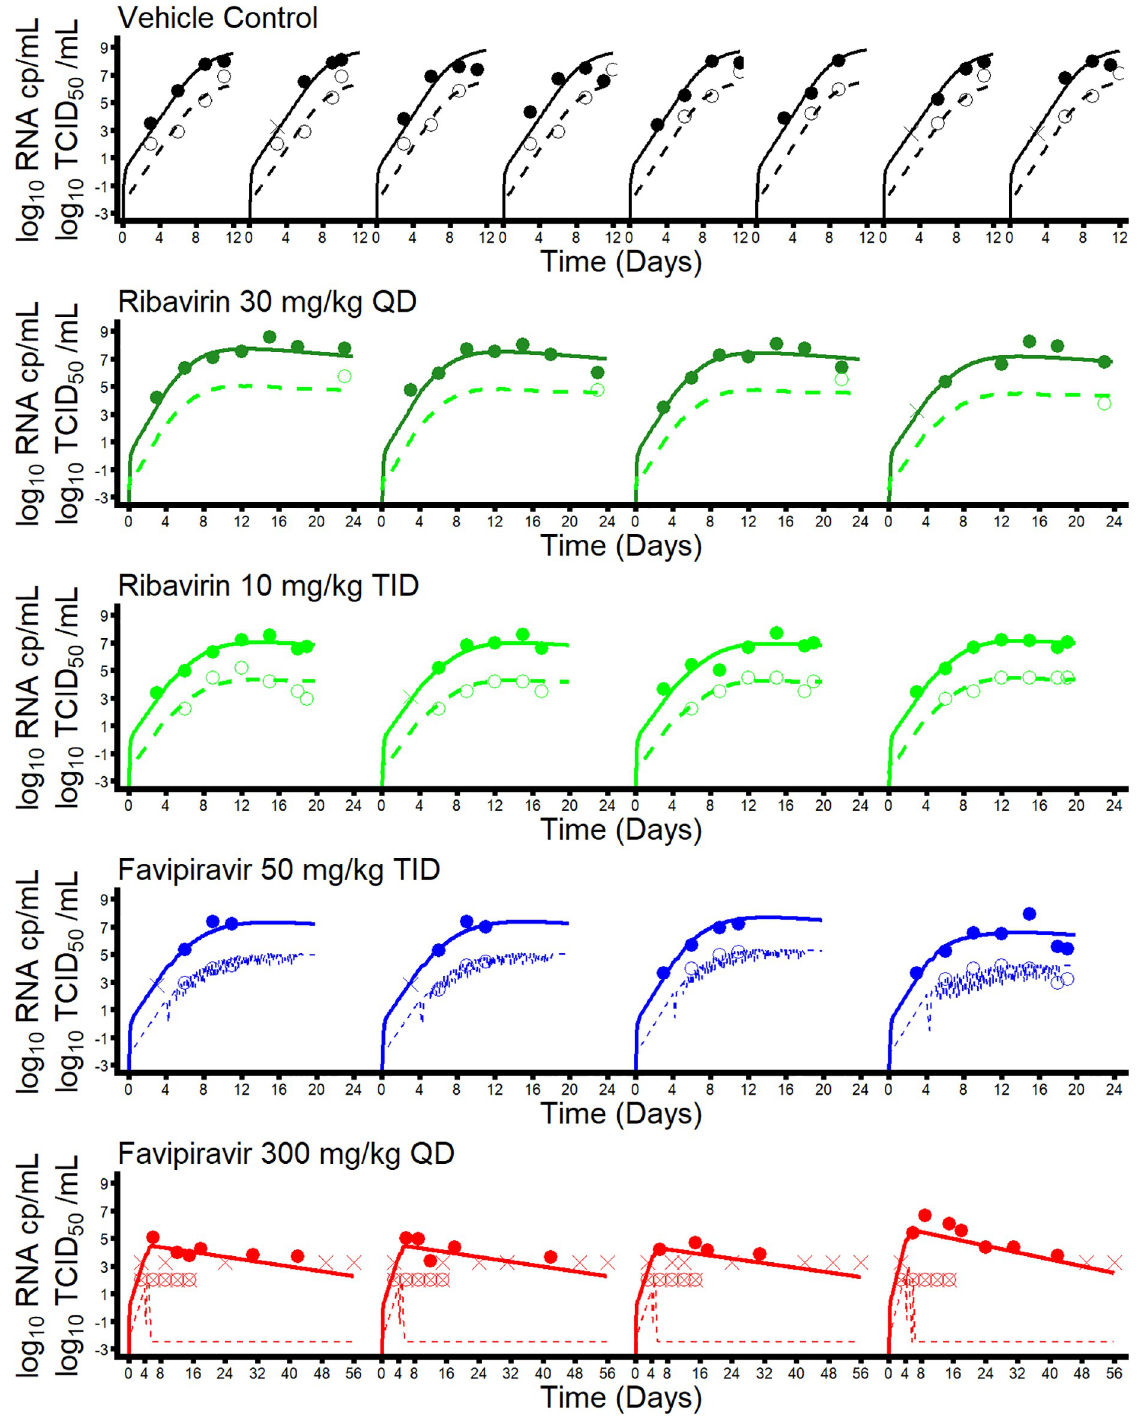
Fig 3. Individual fits of viral load (plain lines) and viral titers (dashed line) for best model considered ( κ = 5). Plain circles represent observed viral loads and empty circles represent observed viral titers. Data below the limit of detection were represented by crosses (viral load) or crossed empty circles (viral